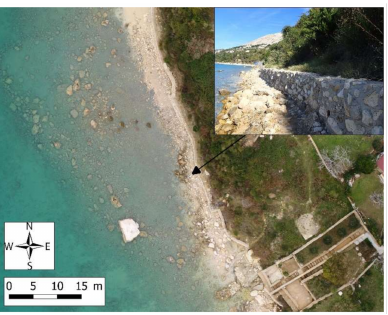
Figure 15. Improvised retaining wall near the landslide